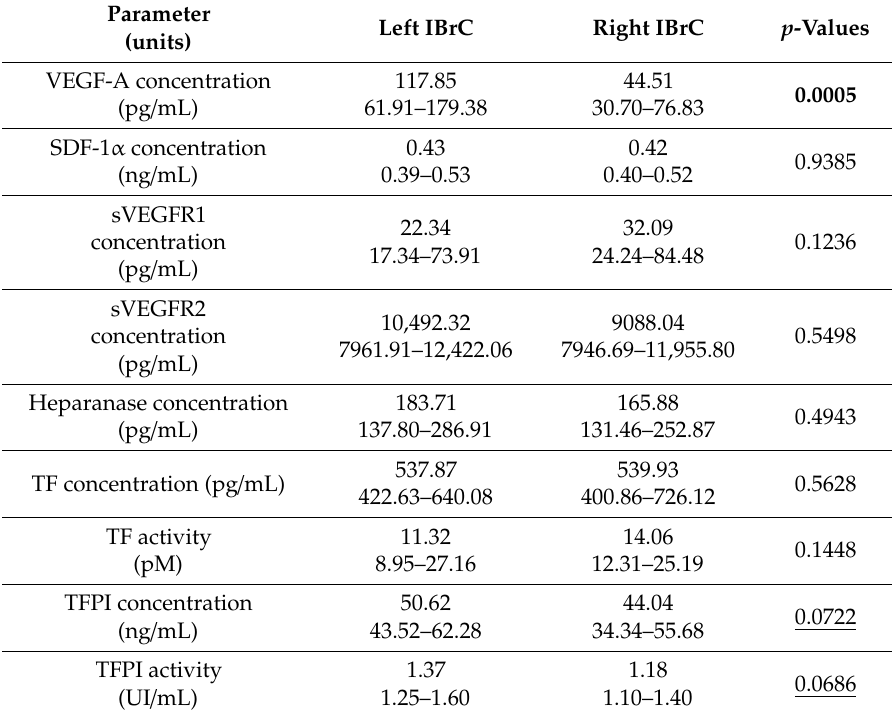
Table 5. Angiogenic, hemostatic, and inflammatory biomarkers according to breast cancer laterality in luminal A breast cancer